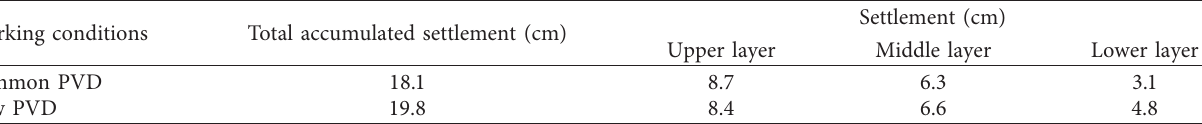
Figure 7: Variation curve of layered settlements with time: (a) common PVD; (b) new PVD. Table 2: Comparison of layered settlement in different